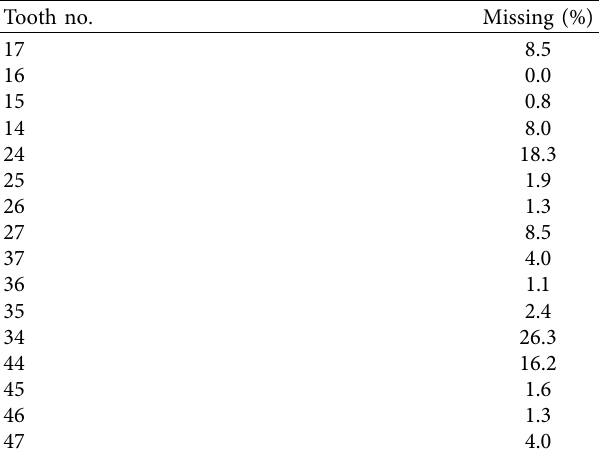
Table 2: Proportions of teeth not fully seen in the radiographs. Tooth no. Missing